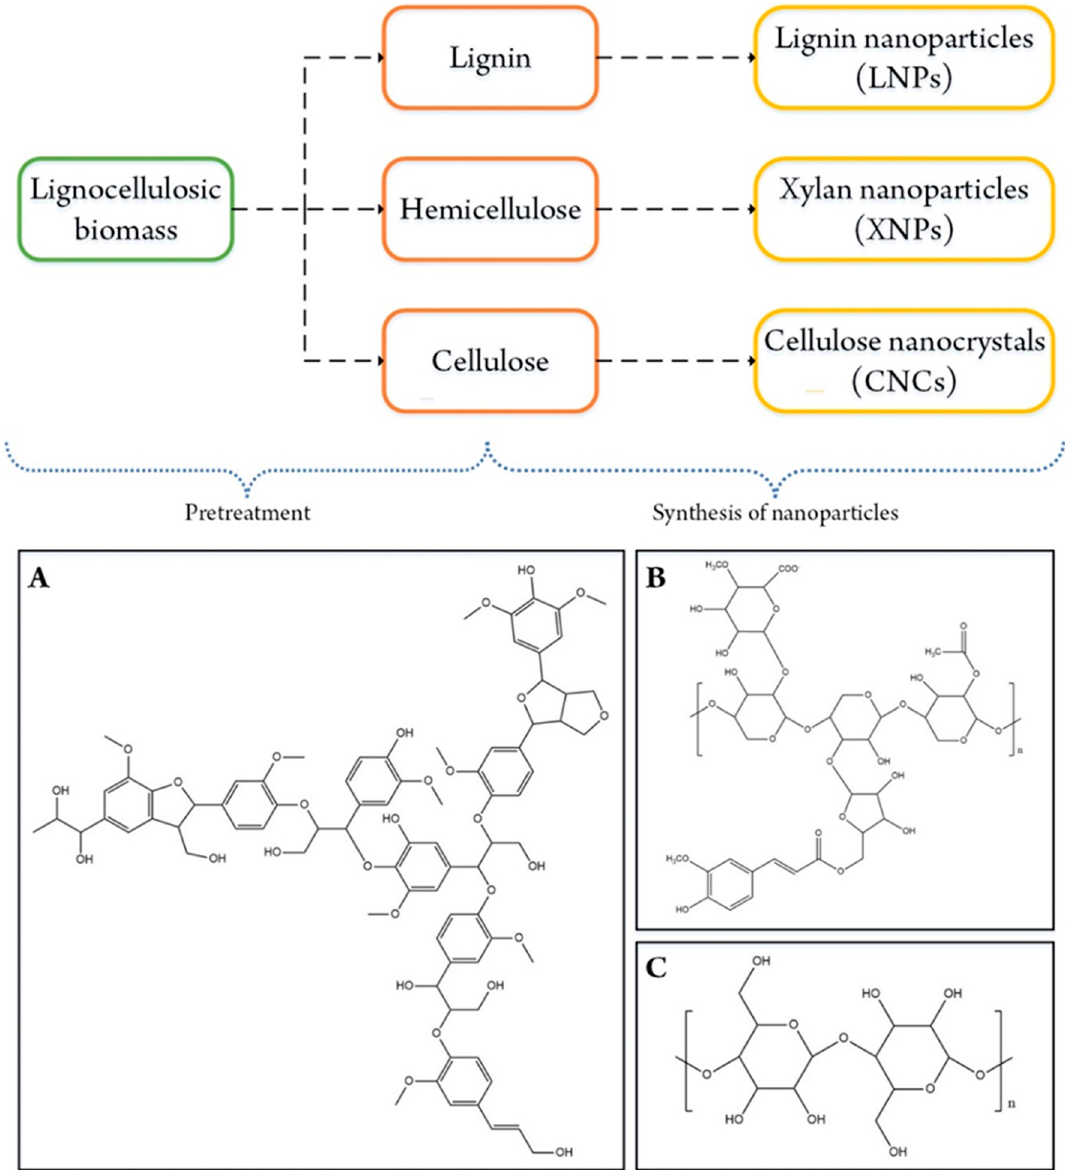
Figure 1. The route of lignocellulosic biomass to lignocellulosic-derived nanoparticles accompanied by the chemical structures of ( A ) lignin, ( B ) hemicellulose, and ( C ) cellulose.